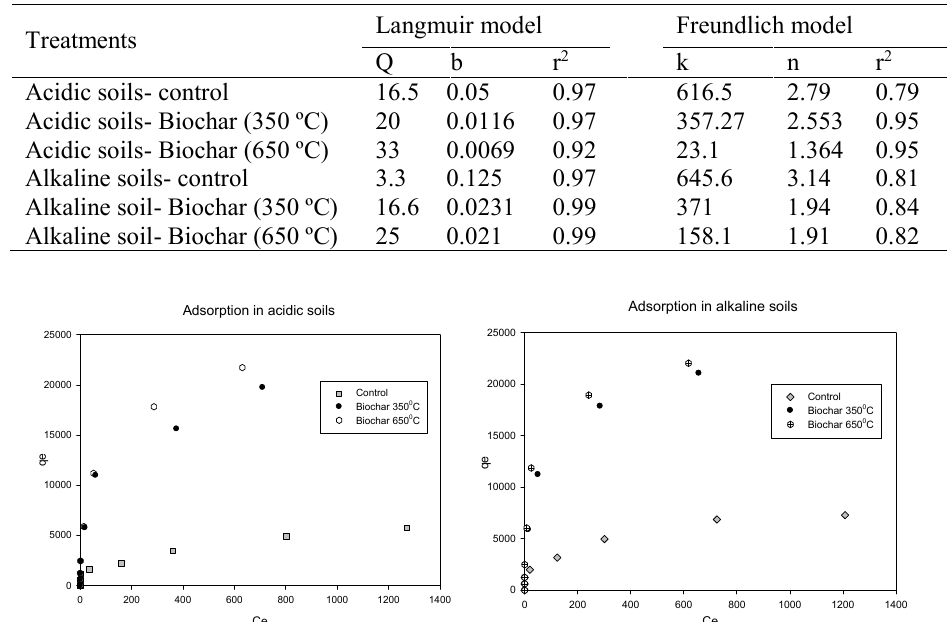
Fig. 1. The relationship between the amounts of qe (mg g–1) of the adsorbed Pb onto the soils and their concentration in the equilibrium solution Ce (mg/L) for studying